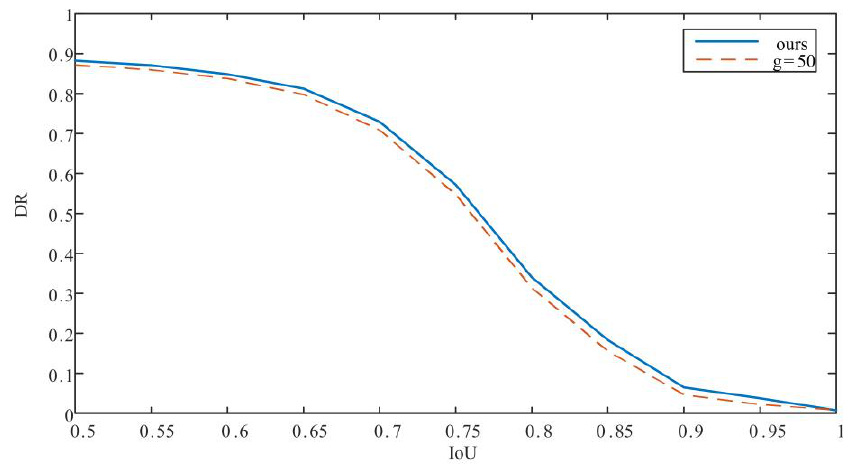
Figure 10. Results with different loss functions.